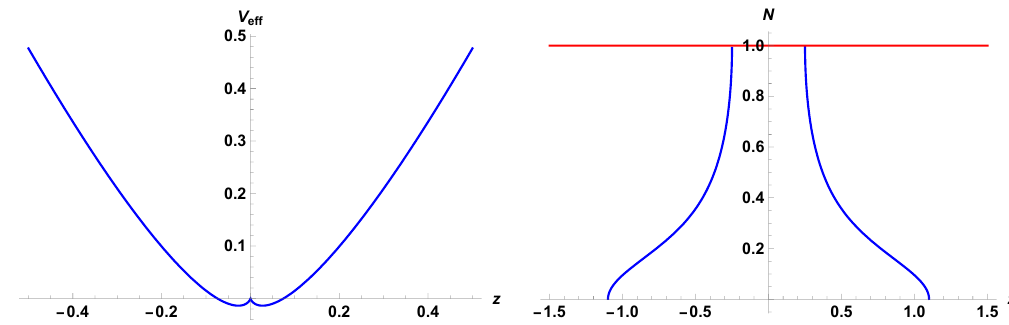
Figure 3 . In the left plot we depict the typical effective potential for small ξ eff = ξR − R/ 2 (single well) and in the right one the typical density of boxes that contains a region of saturation near u = z 2 = 0